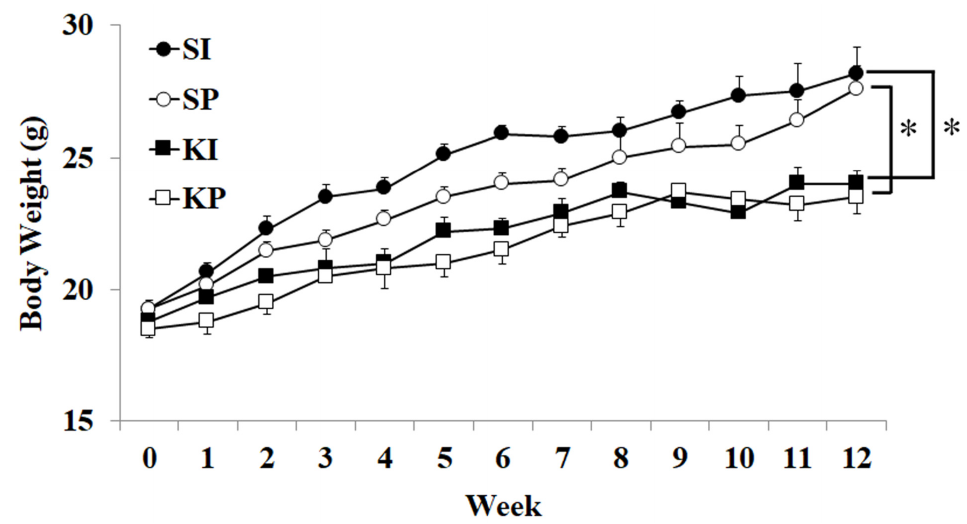
Figure 2. Ketamine inhalation and body weight change. KI and KP mice had lower body weights than SI and SP mice from the fourth weeks onward ( p < 0.05). The values are expressed in means ± SD. An asterisk indicates a significant difference in Bonferroni post-tests following two-way ANOVA ( p < 0.05).